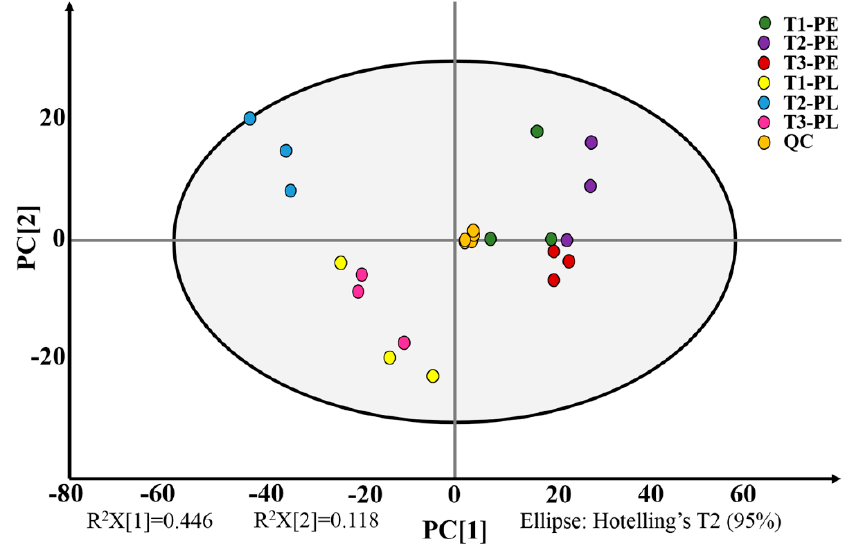
Figure 1. Score scatter plot for principal component analysis with quality control (QC). T1, NH 4 + :NO 3 − = 0:100; T2, NH 4+ :NO 3 − = 25:75; T3, NH 4+ :NO 3 − = 50:50, PE, pericarp; PL, placenta. R 2 X: The interpretation of X variable.